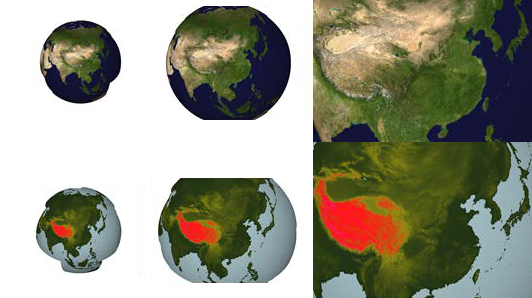
Figure 11. Image and DEM visualization based on SDOG- ESSG (Different View Angle) Figure 10. Global image and DEM visualization based on SDOG-ESSG (Different Level) As the development of hardware technique, especially GPU parallel computing, it is a possible way to combine the GPU parallel computing and SDOG-ESSG model visualization together, and this will be our future research issues. Table 3. Rendering efficiency based on